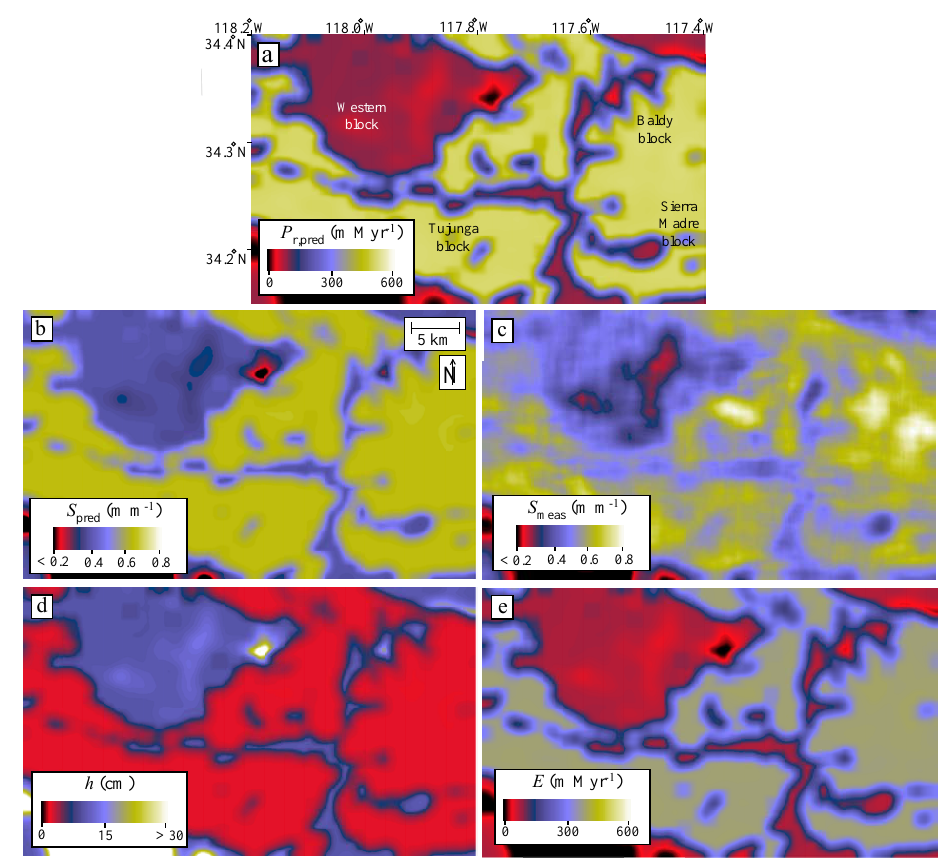
Figure 7. Color maps illustrating the predicted potential soil production rate from Eq. (6) ( P r , pred ), predicted and observed values of average slope, S av , soil thickness, h , and erosion rate, E . (a) Color map of P r , pred values estimated from Eq. (6). (b) Color map of S av values predicted by Eq. (11), smoothed by a moving average filter with a 1km length scale to emphasize patterns on the landscape scale. (c) Color map of actual (digital elevation model derived) S av values, smoothed in the same manner as panel (b) . (d) Color map of soil thicknesses, h , predicted by Eq. (10). (e) Color map of erosion rates, E predicted by Eq. (8).